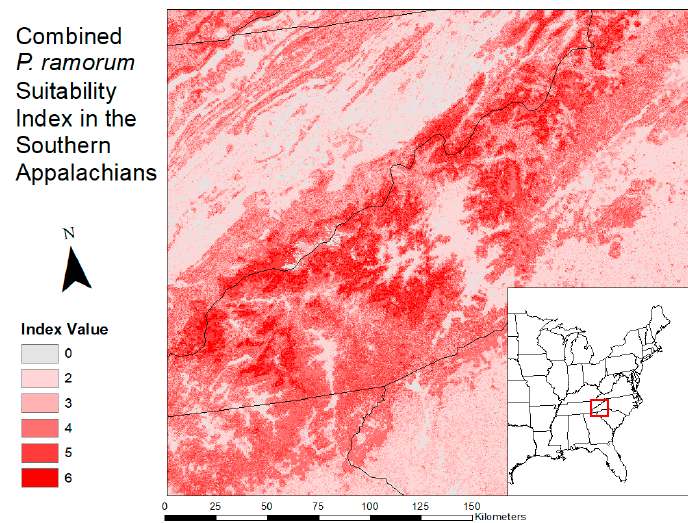
Figure 6. Combined index values within the specific context of a highly suitable area in the southern Appalachians. Resolution: 250 m.